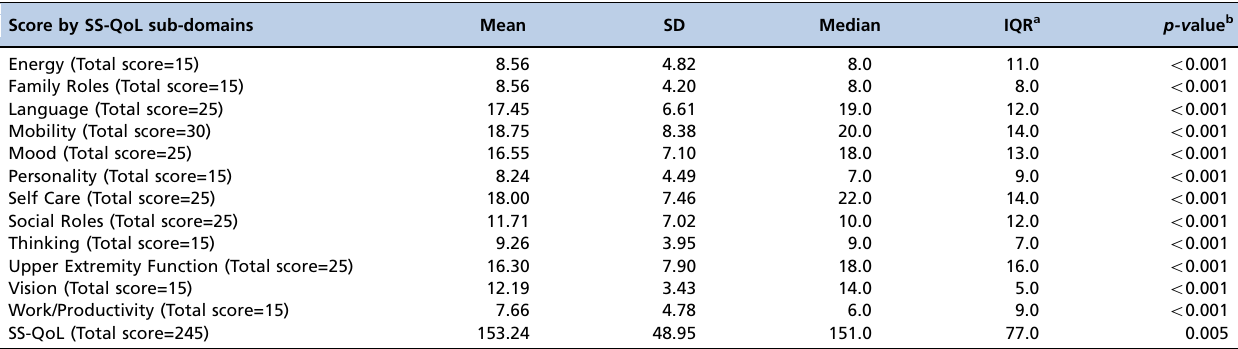
Table 2 - Score of the Stroke Specific Quality of Life Scale in patients with ischemic stroke . Score by SS-QoL